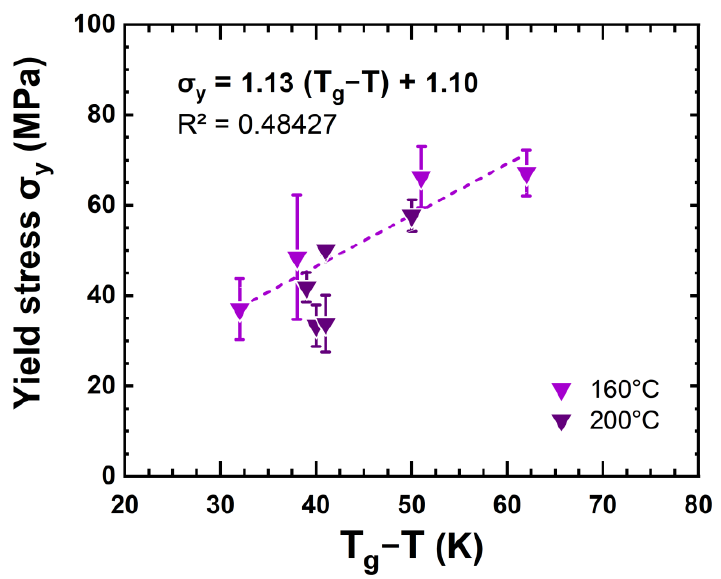
Figure 8. Stress at yield vs. glass transition and carbonyl concentration for DGEBA-TTDA.